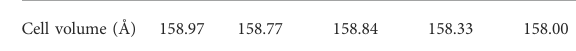
TABLE 1 Cell volumes derived from the XRD patterns of samples with different TiO 2